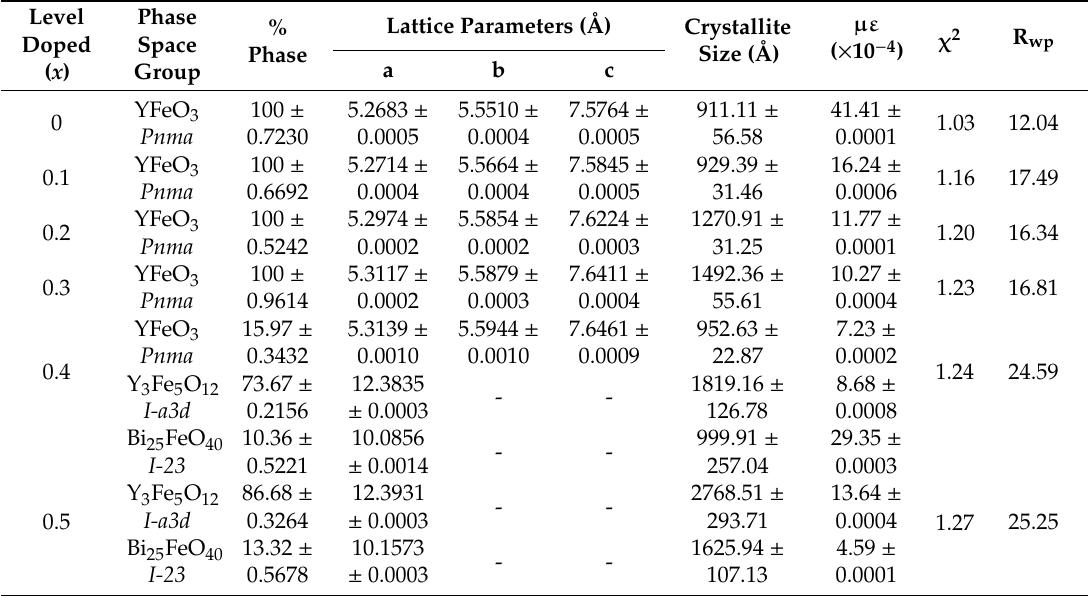
Table 1. Rietveld analysis of the XRD patterns to Y 1 − x Bi x FeO 3 pellets of all